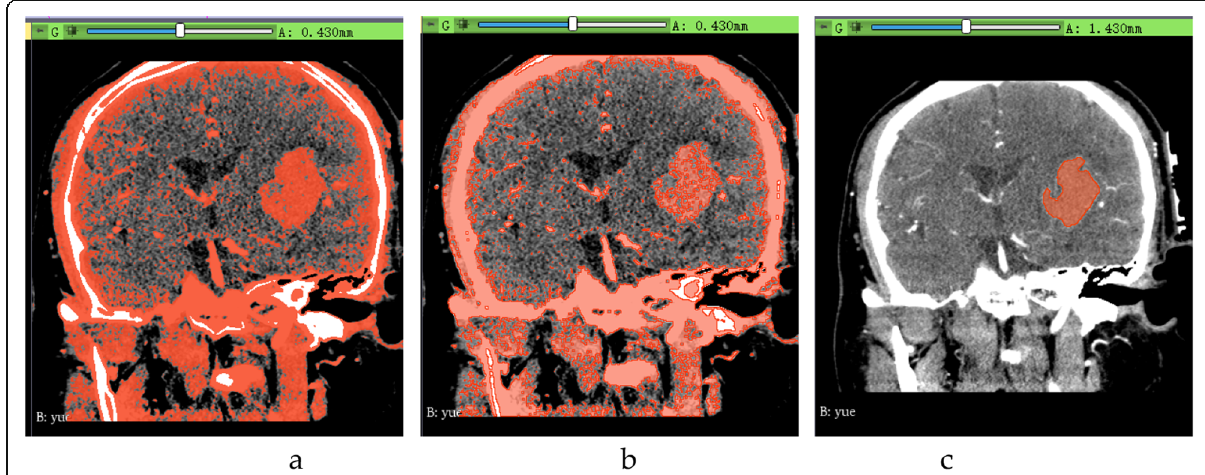
Fig. 2 Schematic diagram of hematoma extraction. a Mask effect; b Smoothing; and c hematoma segmentation